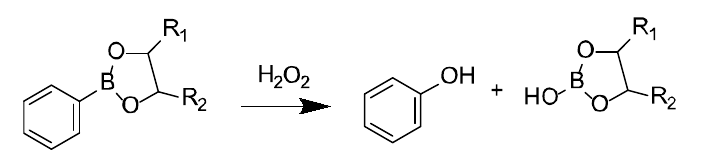
Figure 1. Bonding equilibrium between phenylboronic acid (PBA) and diol.